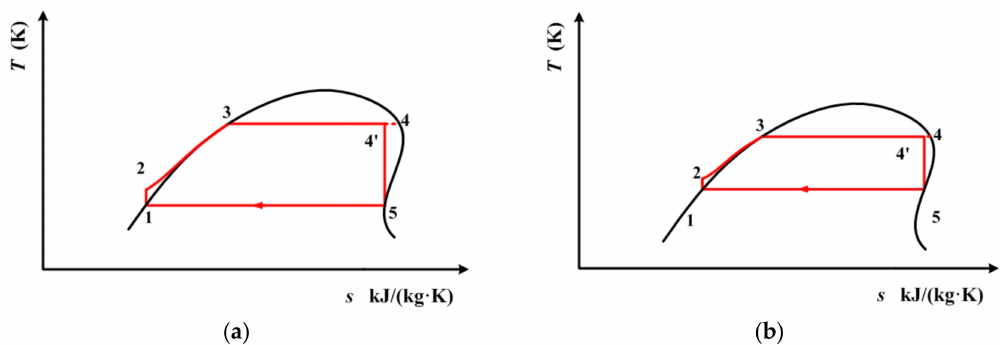
Figure 7. Subcritical ORC for R1234yf and R1234ze(E) with a single-screw expander when the condensation temperature is known: ( a ) 290 K, ( b ) 320